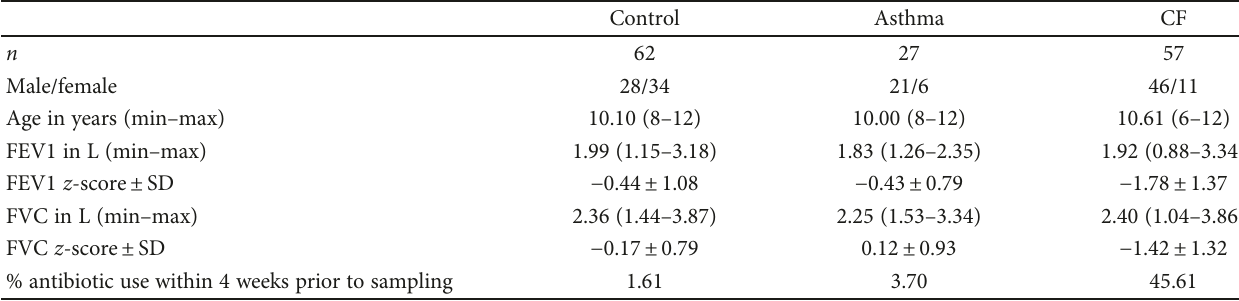
Table 1: Demographic description of the